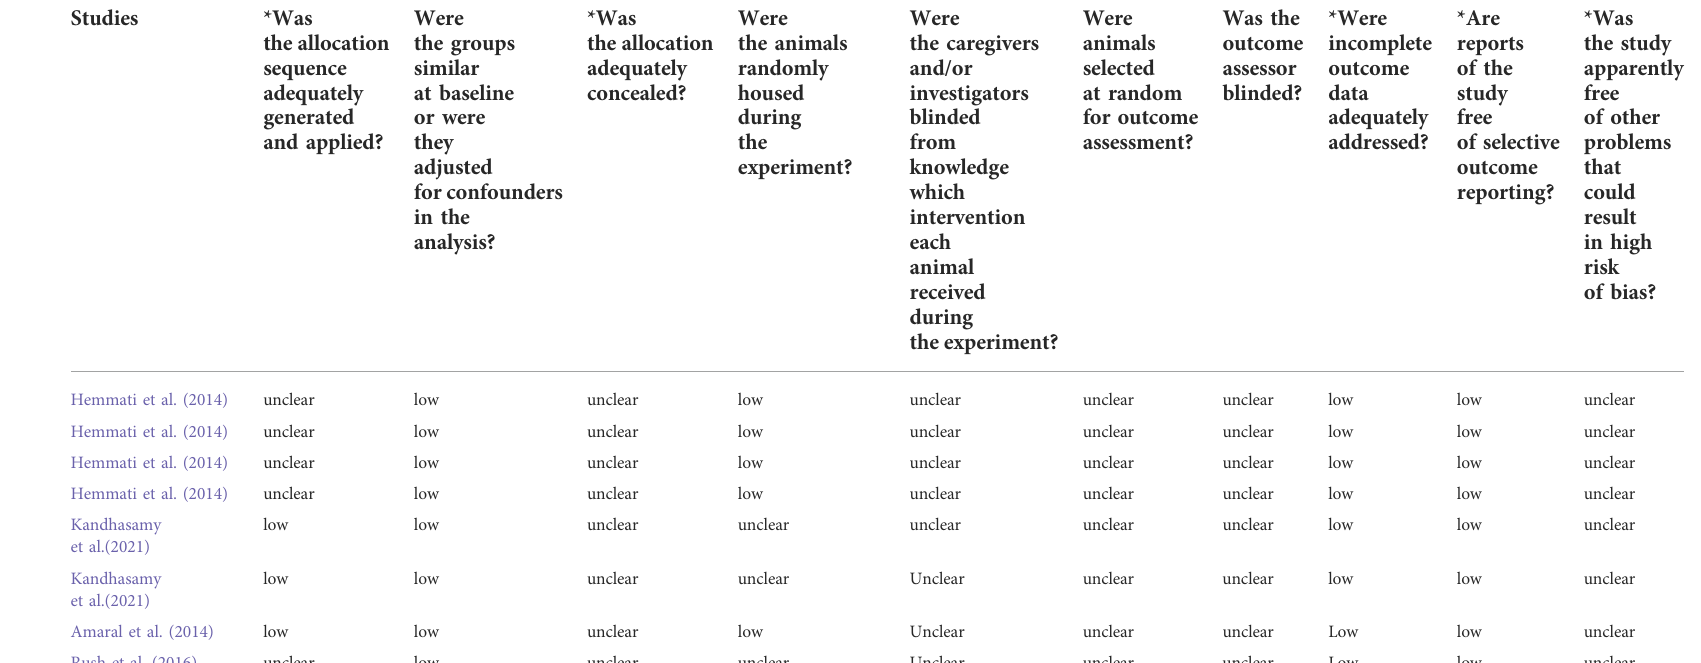
TABLE 2 SYRCLE ’ s tool for assessing the risk of bias in animal studies. Studies